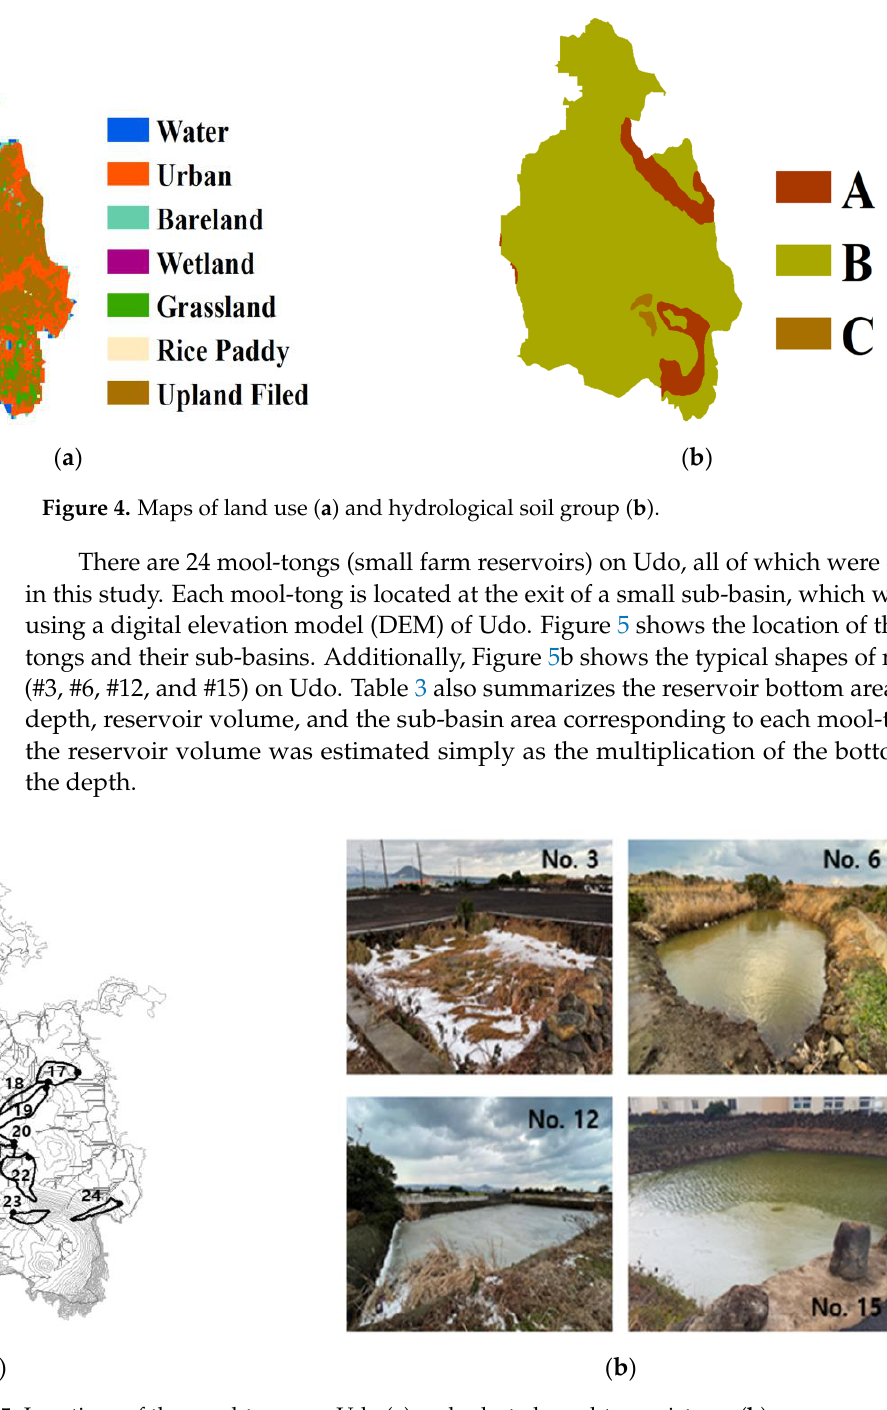
Figure 5. Locations of the mool-tongs on Udo ( a ) and selected mool-tong pictures ( b ). Table 3. Basic characteristics of the mool-tongs considered in this study.